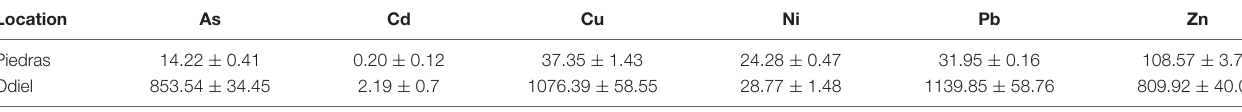
TABLE 1 | Metal(loid) concentrations in mg Kg − 1 in sediments from Odiel to Piedras salt marshes used in this study. Location